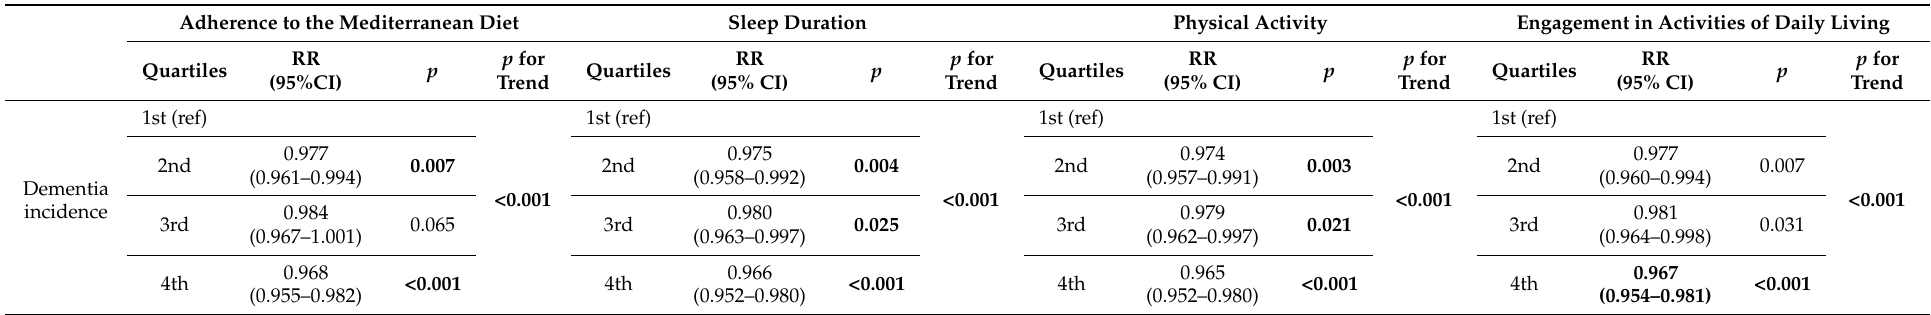
Table 5. Results from Generalized Estimating Equations that evaluated the association between quartiles of individual lifestyle factors based on the distribution of composite z-score at baseline for each specific lifestyle factor (independent variables) with dementia incidence (dependent variable) in non-demented participants at